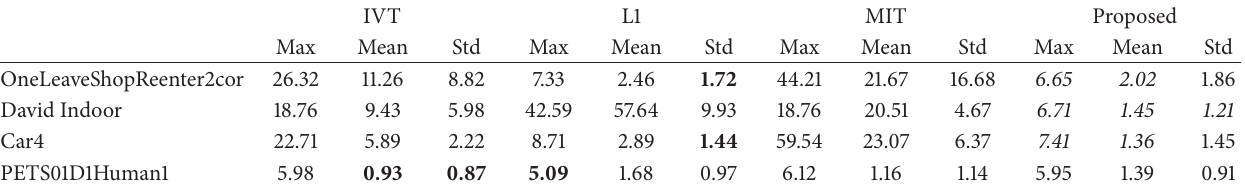
Table 1: Analysis of location